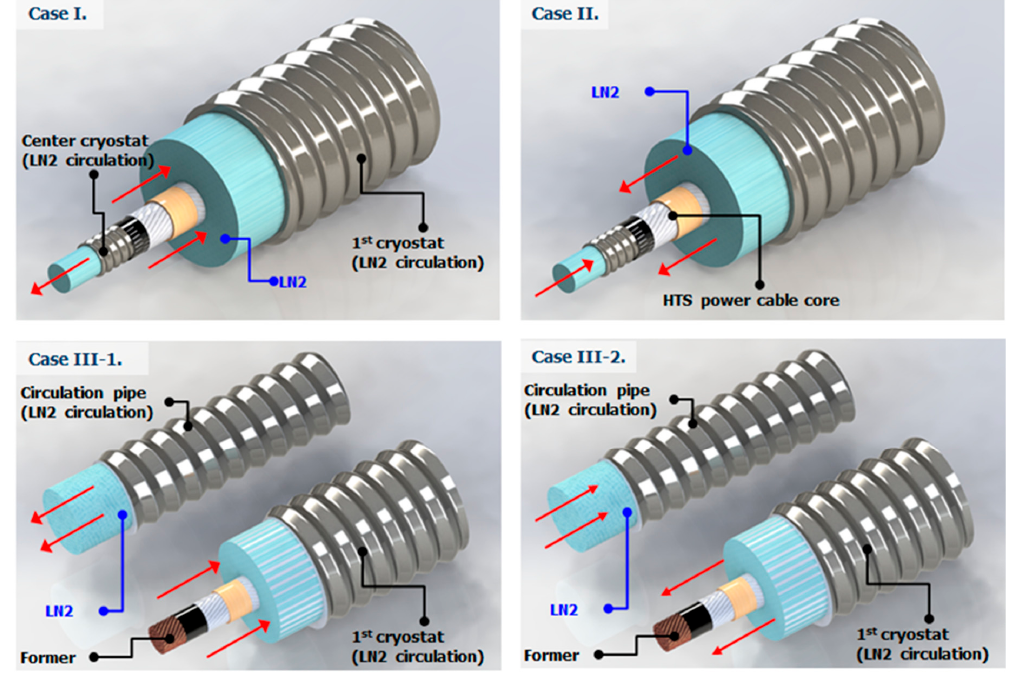
Figure 2. Cases of LN2 circulation structure. Table 1. Comparison of cooling circulation methods of three-phase coaxial superconducting power cable.